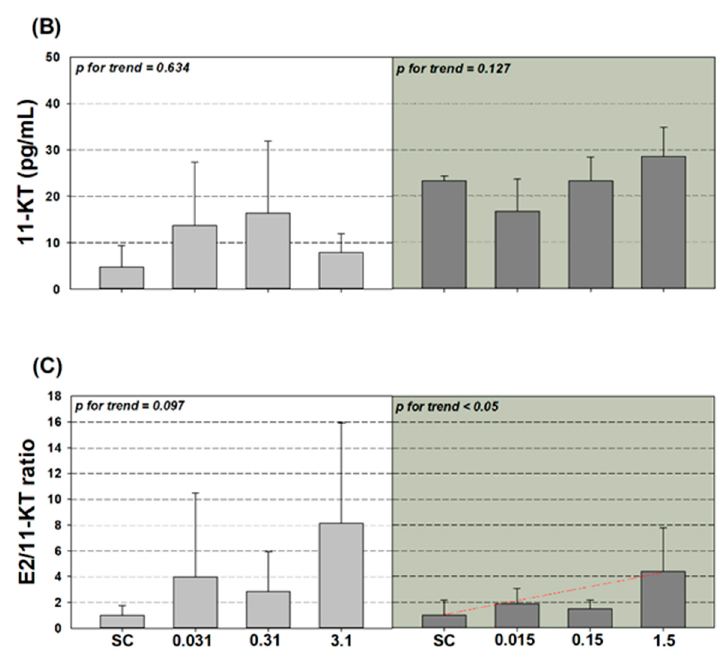
Figure 1. Effects on sex hormones of ( A ) 17 β -estradiol (E2), ( B ) 11-ketotestosterone (11-KT), and ( C ) E2/11-KT ratio in male zebrafish exposed to DBDPE and BTBPE. The results are shown as mean ± SD of quadruplicates ( n = 4). Asterisk indicates a significant difference relative to the solvent control (0.1% DMSO, p < 0.05). The value of p for trend was determined based on the linear regression analysis. If p for trend was < 0.05, a linear trend is indicated with a red dotted line.